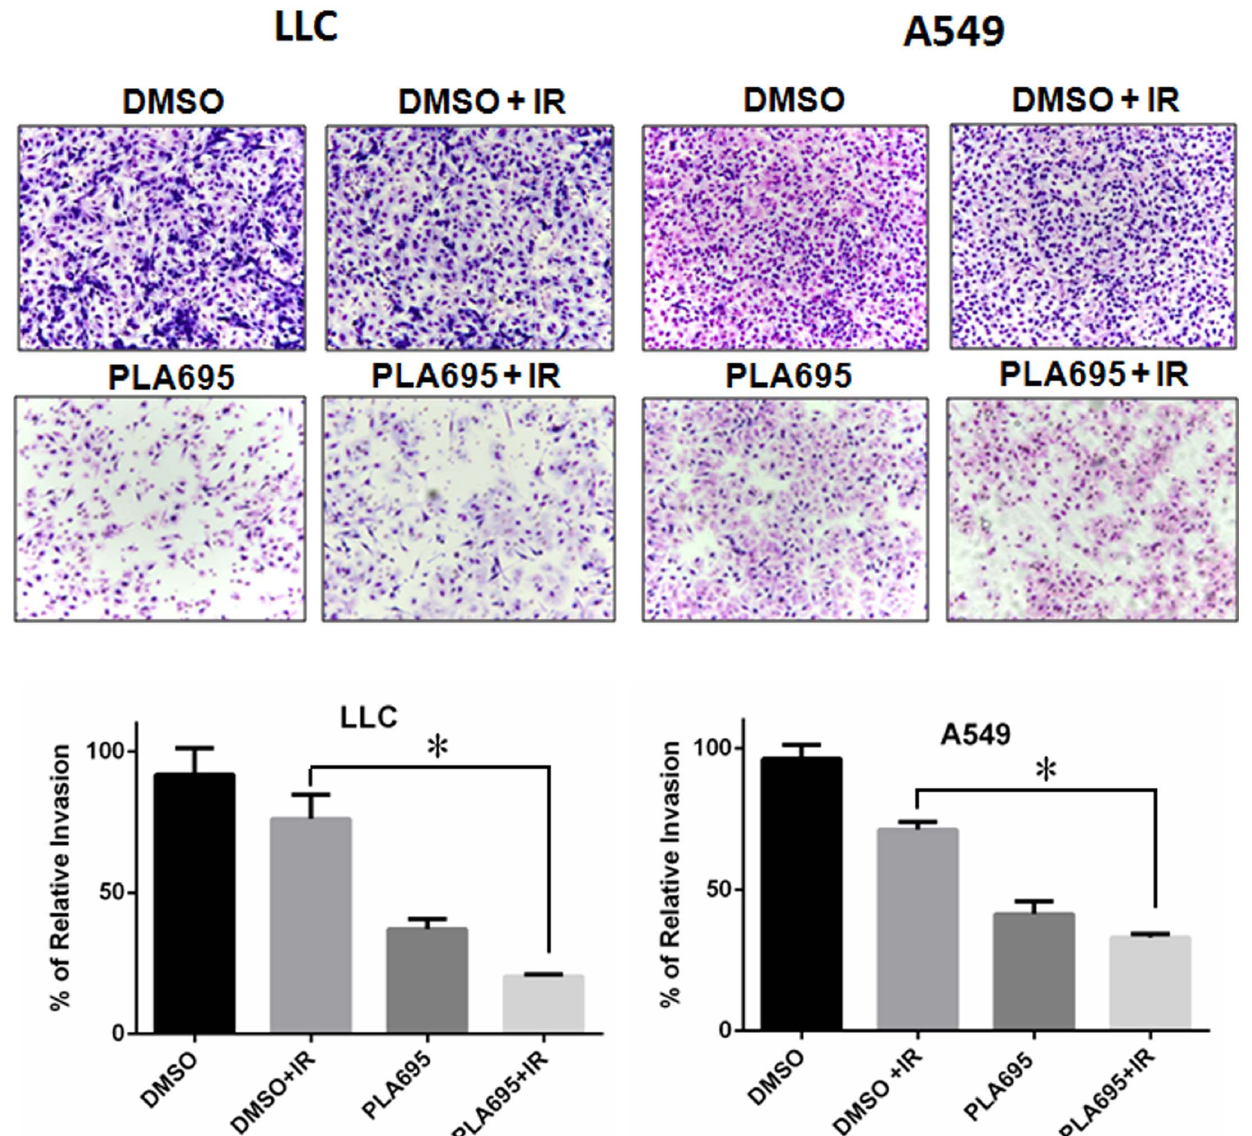
Figure 6. PLA-695 reduces tumor cell invasion after radiation. LLC and A549 cells were added to the 8 micron inserts and were treated with 300 nM PLA-695 or DMSO for 45 minutes prior to 3 Gy irradiation. Cells were allowed to invade/migrate from the top chamber through the coated filter pores to the complete medium at the bottom of the inserts for 48 hour. Cells were then fixed, stained and cells that invaded through the membrane was calculated by counting the number of cells per HPF. Shown are representative photomicrographs and a bar graph representing the number of invasive cells with SEM; * p . 0.05.